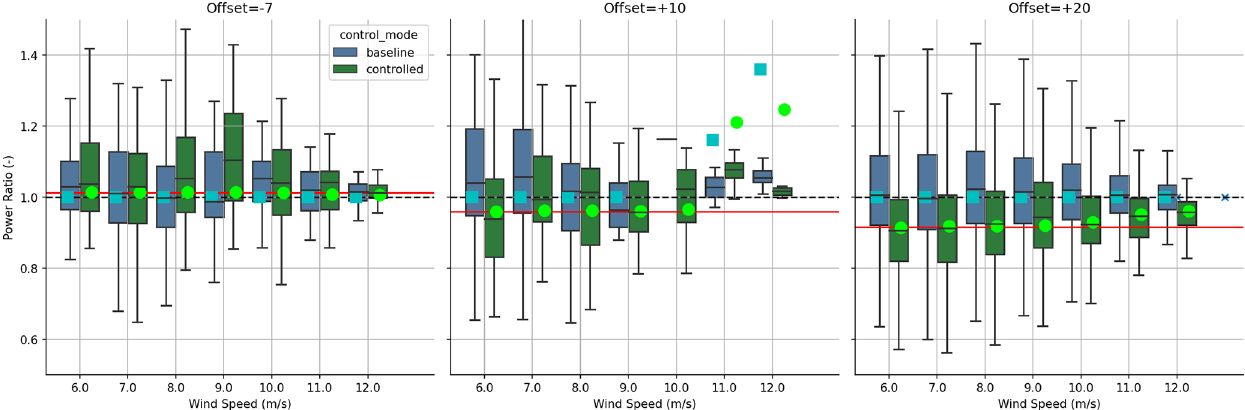
Figure 5. A comparison of power ratios of the controlled wind turbine (T5) with respect to the reference turbine (T4) for different target offsets. The power ratios are binned by wind speed, and the results for baseline (blue) and controlled operation are compared. The circles indicate the expectations from the FLORIS model, whereas the red horizontal line is assuming a fixed cosine-squared loss.